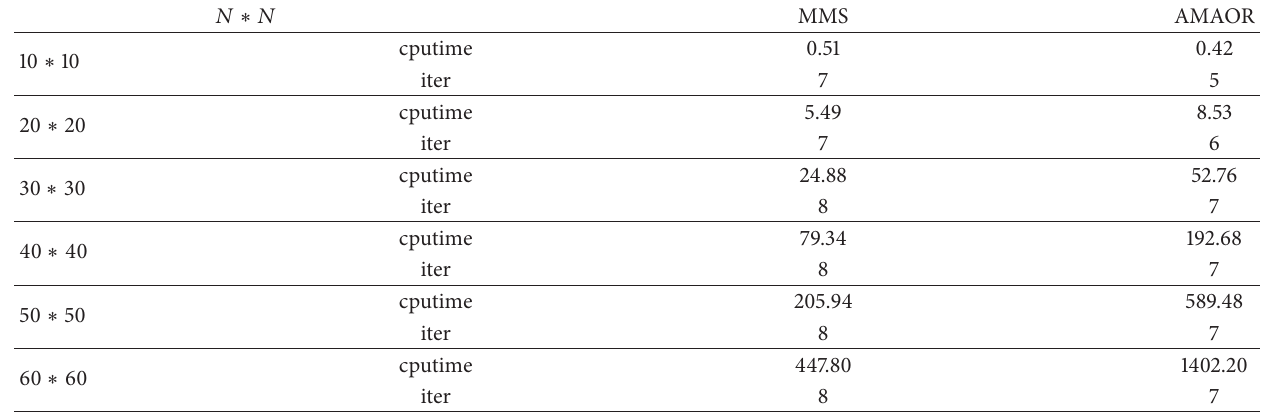
Table 4: Comparison of MMS and